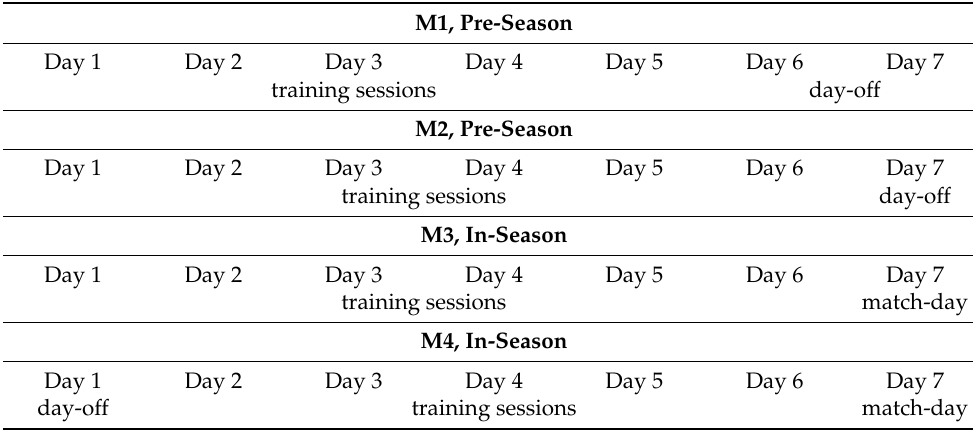
Table 1. Weekly training characterization of Ms from pre- and